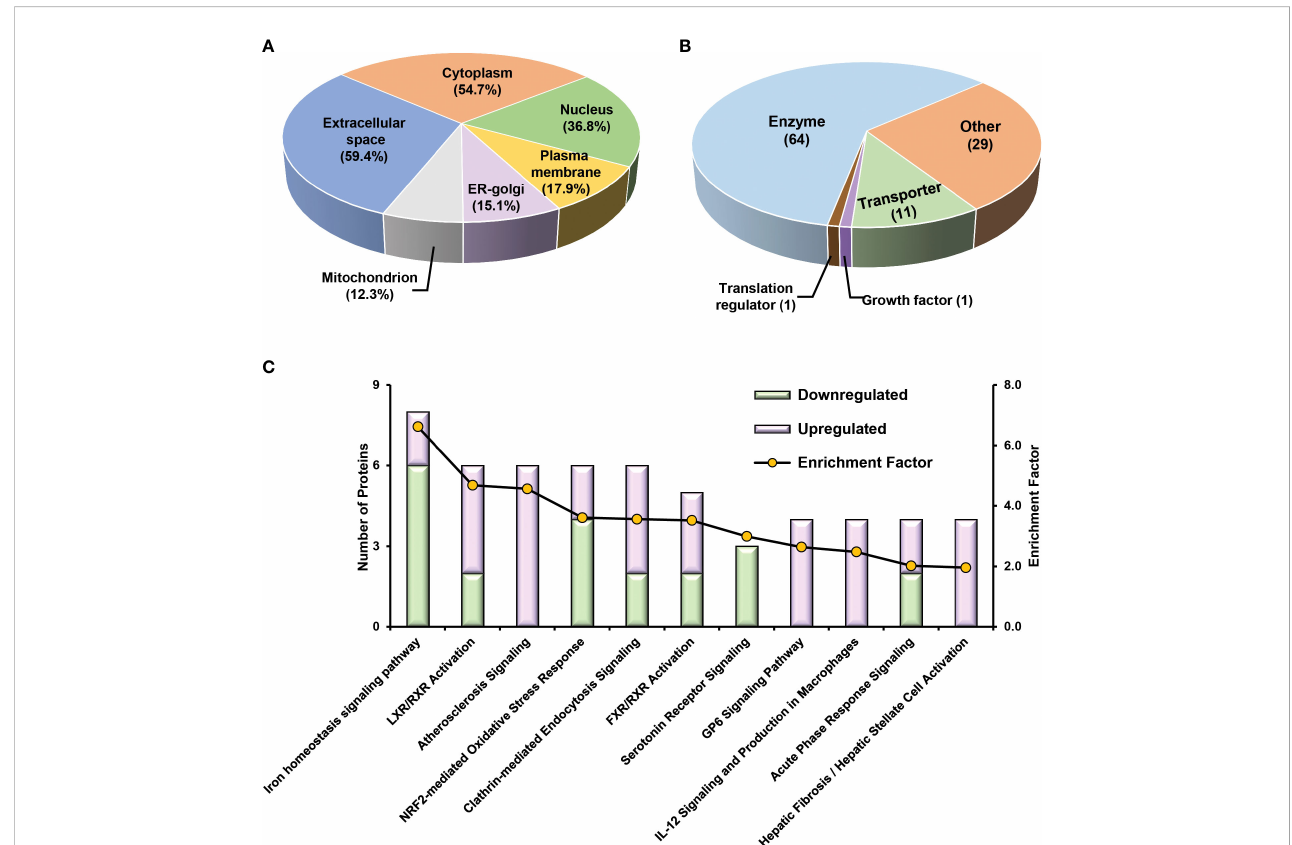
FIGURE 6 Bioinformatics analysis of 106 potential classi fi ers between TCMR and STA commonly quanti fi ed from two methods. Ingenuity Pathways Analysis of cDEPs commonly identi fi ed from both TMT- and label-free quantitative proteome analysis revealed cellular component (A) , molecular function (B) , and canonical pathways (C) enriched in the 106 potential classi fi ers between TCMR vs. STA samples. The orange and green labeled bars respectively represented the up-regulated and down-regulated proteins in TCMR in comparison with